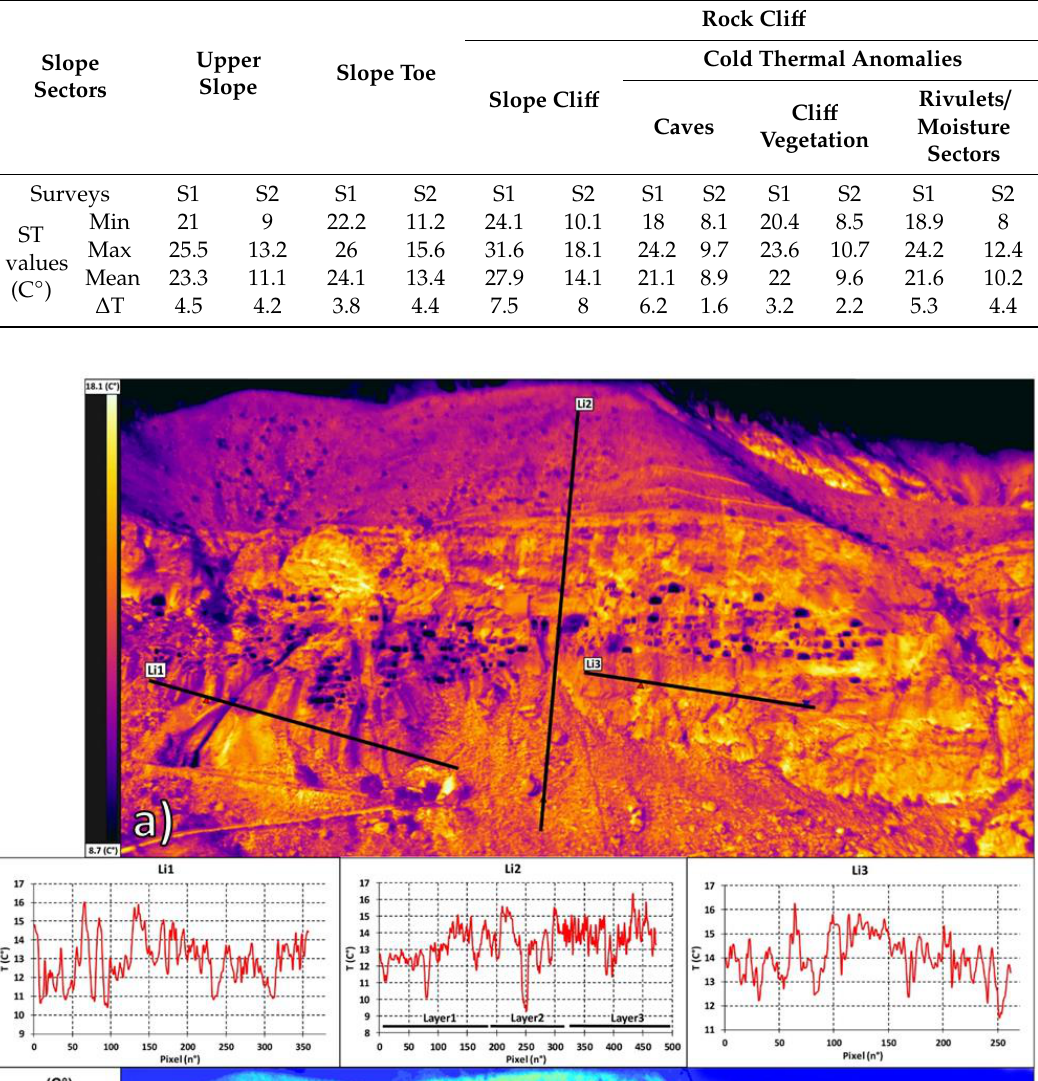
Table 4. SST values measured in the various slope sectors.